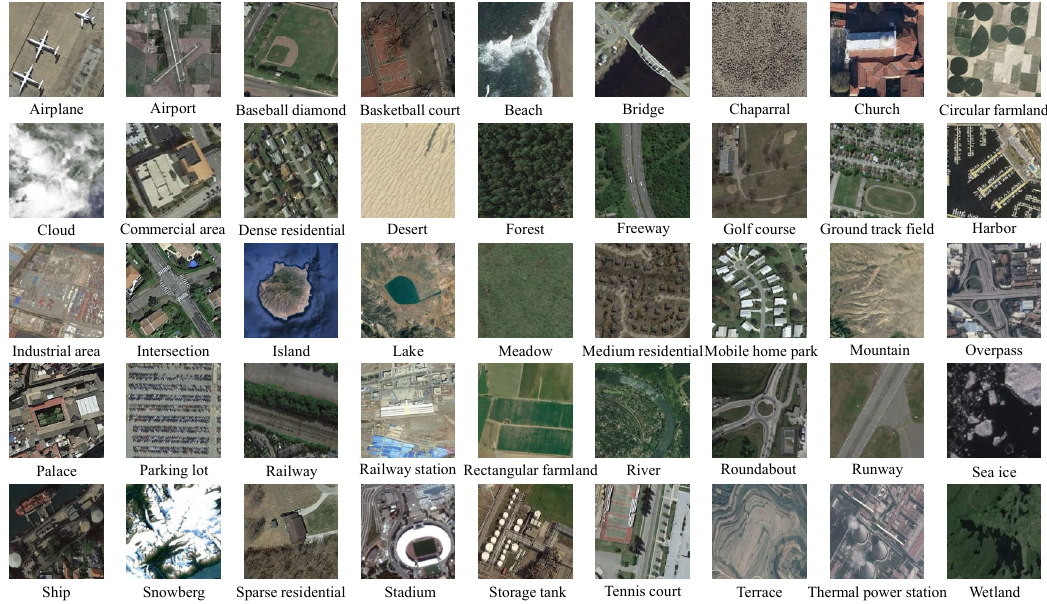
Figure 7. Example images of each category in the NWPU-RESISC45 dataset. RSD46-WHU is a large-scale open dataset for remote sensing image scene